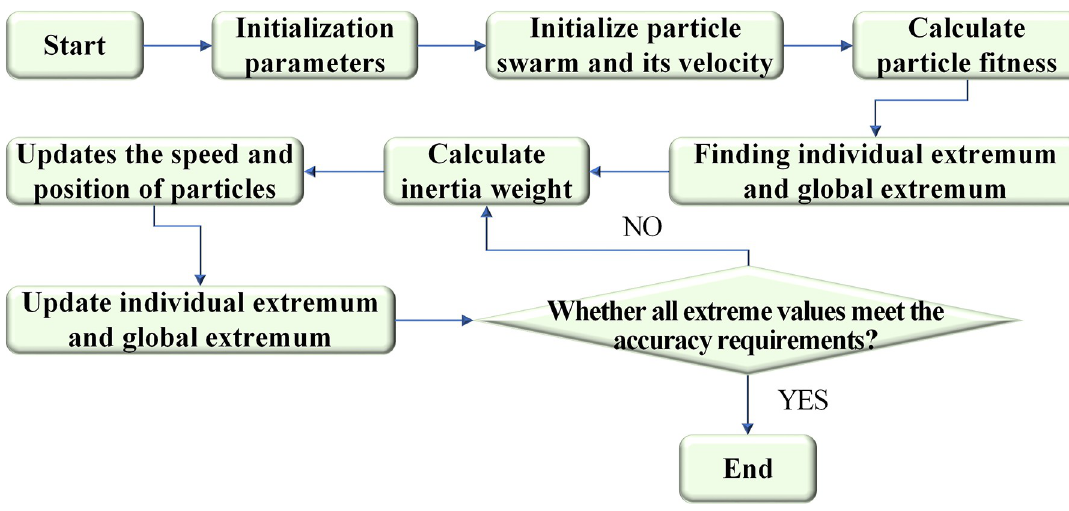
Fig 4. Algorithm flow.